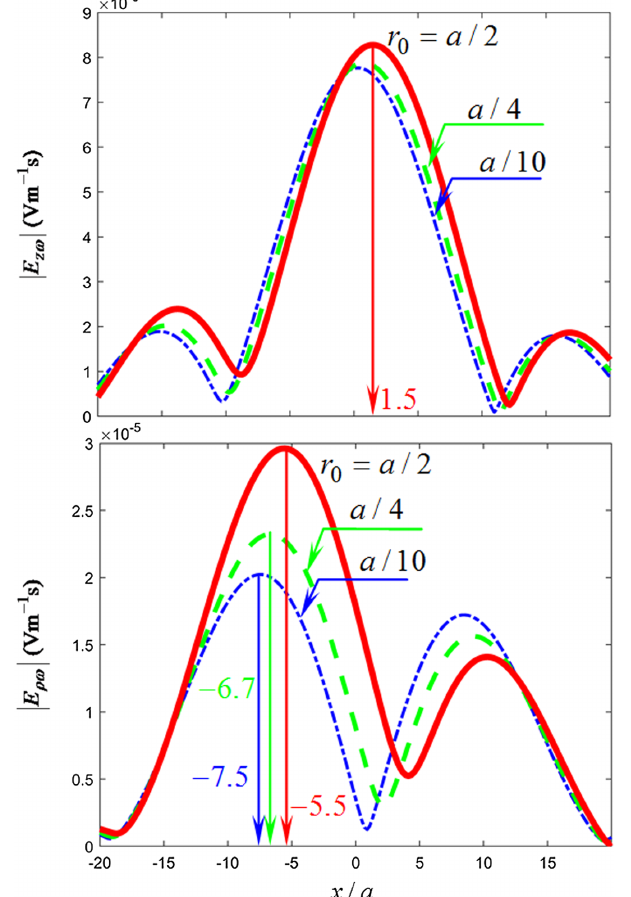
FIG. 2. Dependence of absolute values of longitudinal ( E z ω ) and transverse ( E ρω ) field over x for y ¼ z ¼ 0 for three values of charge ’ s shift r 0 ¼ a= 10 ; a= 4 ; a= 2 . Calculation parameters are the same as in Fig.